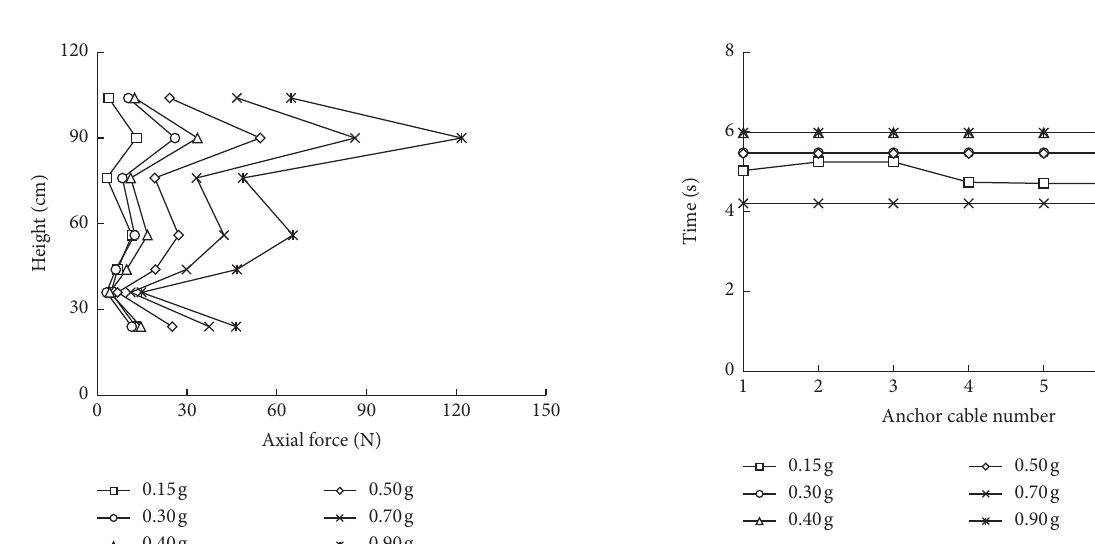
Figure 11: The occurrence time of the peak axial force of all seven anchor